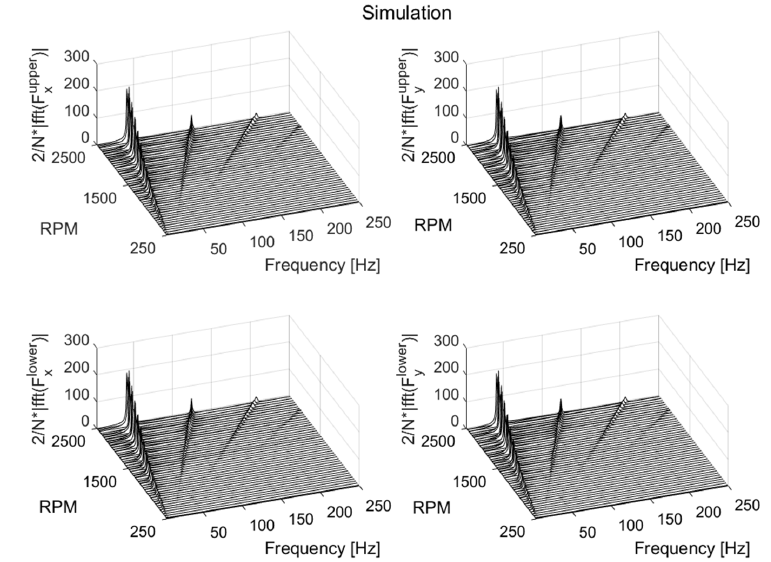
Figure 25. The waterfall diagram of the simulated bearing forces with 5.9 × 10 − 3 kg·m and 2 π rad/s 2 . N is the number of samples.